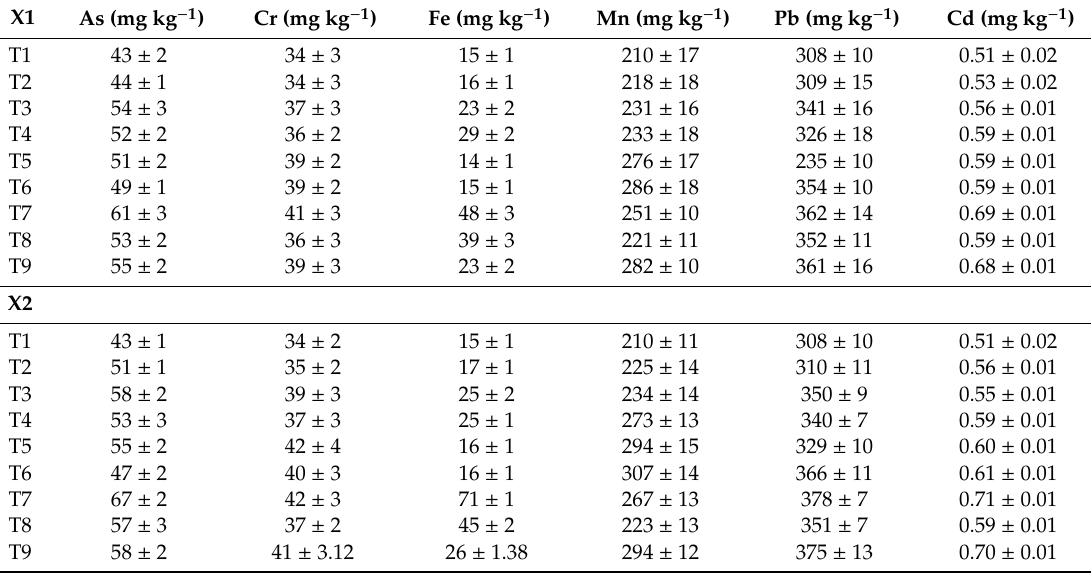
Table 2. Mean value and standard error of total elements in soil (mg kg − 1